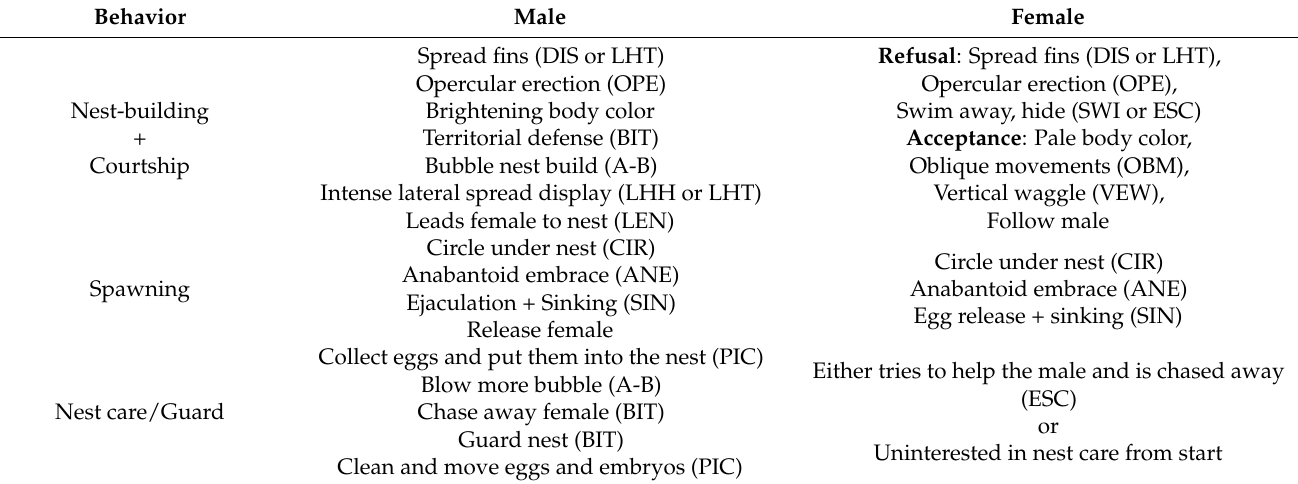
Table 3. The reproductive behavior of M. opercularis , see Reference [5] for